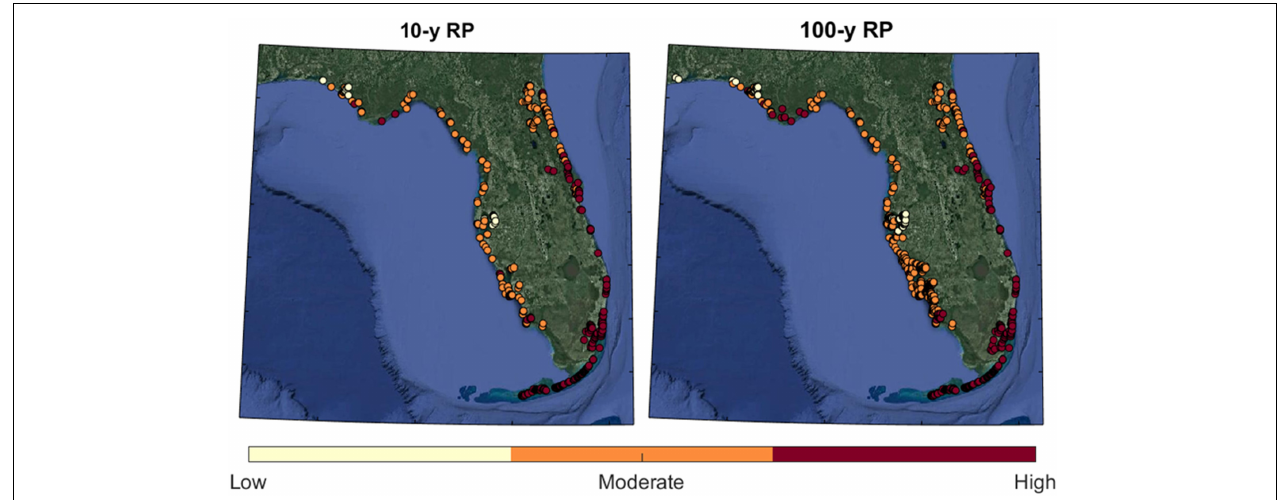
FIGURE 8 | Coastal vulnerability index (CVI) for coastline stretches with landfills located in the 10-year coastal flood plain (left) and 100-year coastal floodplain (right).